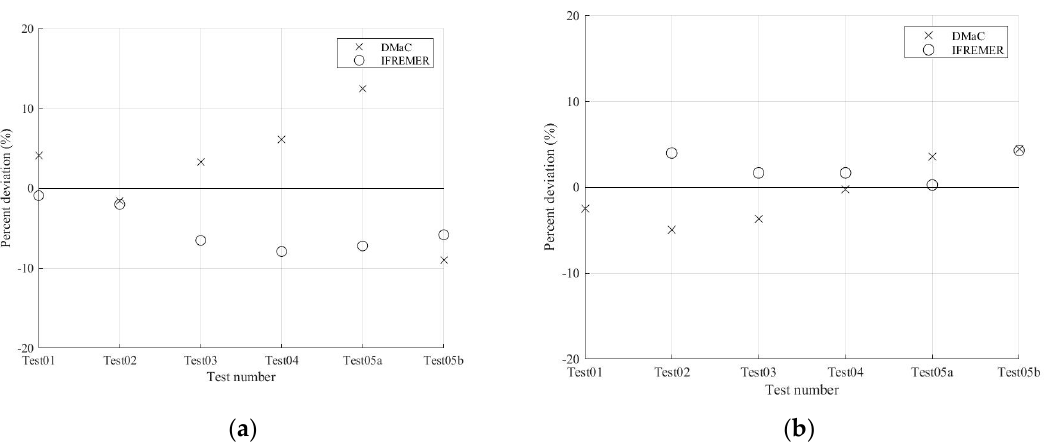
Figure 8. RRT percent deviation of ( a ) End of bedding-in stiffness from mean value of 28.9 kN/% and ( b ) Quasi-static stiffness from the mean stiffness value of 17.4 kN/%.